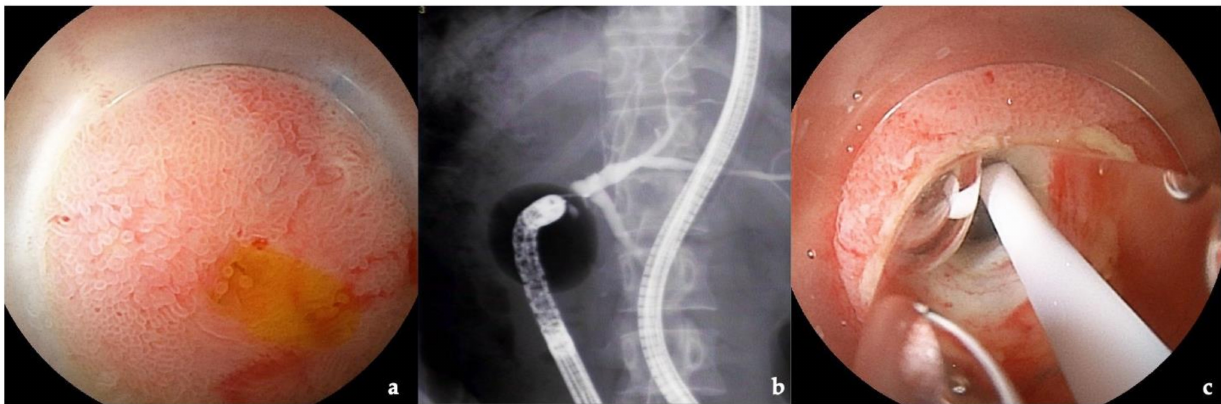
Figure 2. Patients for treatment of stenosis of the anastomosis using balloon enteroscopy-assisted endoscopic retrograde cholangiography: ( a ) status post-living donor liver transplant patient with biliary atresia: balloon enteroscopy-assisted endoscopic retrograde cholangiography showed the anastomosis with a stricture; ( b ) intrahepatic bile duct of the patient was dilated due to a stricture; ( c ) dilation with a balloon